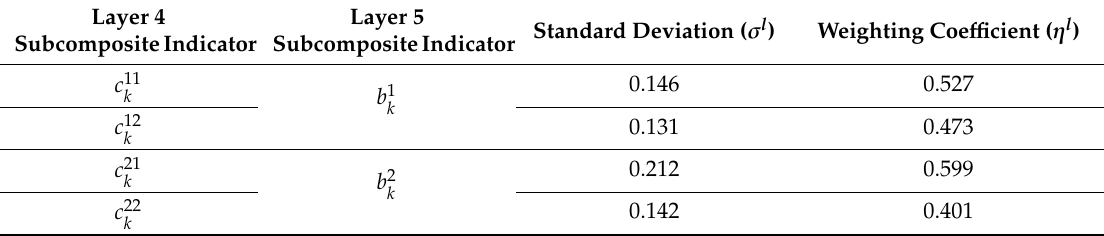
Table 4. Weighting coe ffi cients for calculation of layer 5 composite subindices.